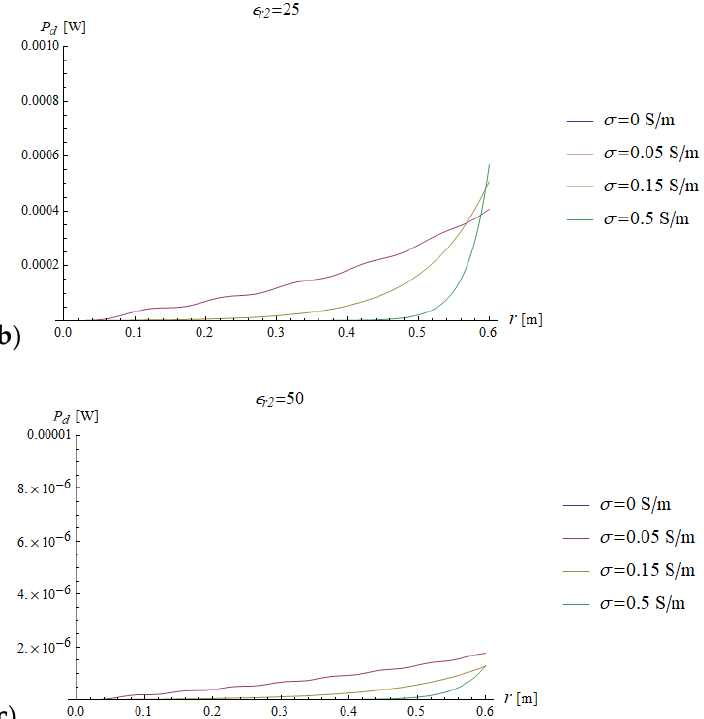
Figure 10. The power dissipated inside a sphere is plotted as a function of the radial coordinate for different values of relative permittivity ( ε r 2 = 5, 25 and 50 in ( a – c ), respectively) and conductivity (see plot legend).